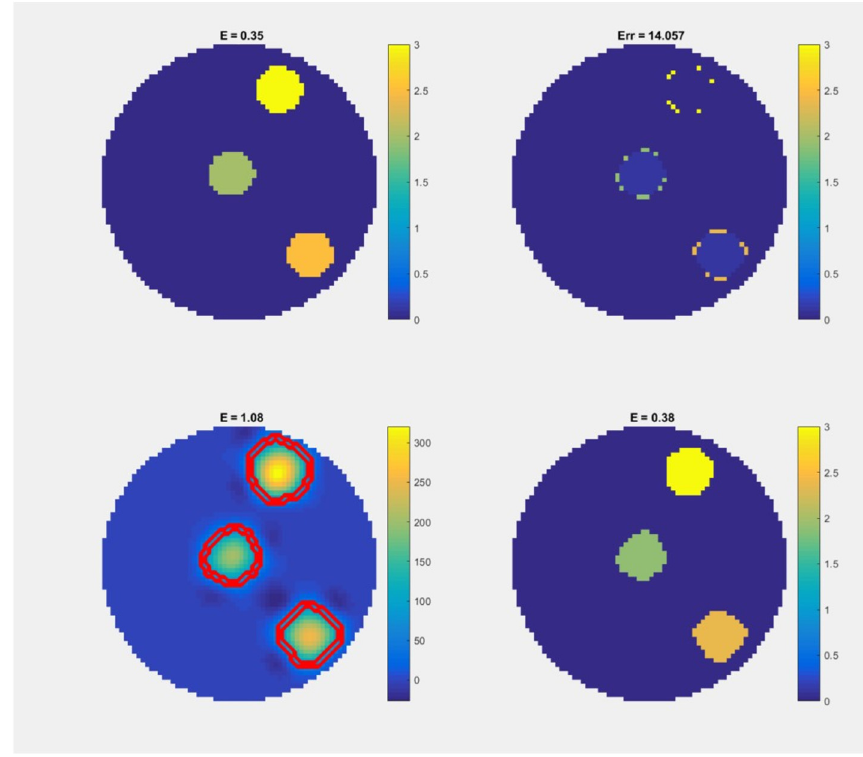
Figure 7. Examples of direct image decompression with filtering for three phantoms. The upper left corner shows the master image. The lower-left corner shows the decompressed image that was additionally segmented (red lines in the image). The image in the bottom right corner shows the desegmented areas—the colour of the desegmented area results from averaging the values in the decompressed image. Finally, the image in the upper right corner is different between the desegmented areas and the reference image.